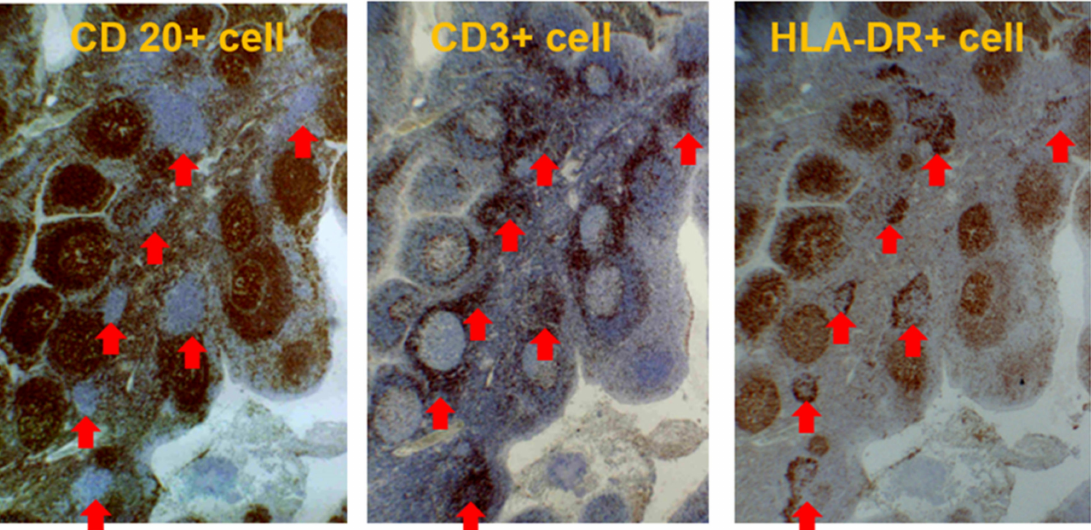
Figure 6. T cell nodules in palatine tonsil. T cell nodules (red arrows) consisting of CD3+CD20-HLA- DR+ cells present in the interfollicular area of the palatine tonsil (original magnification × 40). CX3C chemokine receptor 1 (CX3CR1), the only CX3CL1 (fractalkine) receptor, is expressed in human NK cells, NKT cells, monocytes, CD8+ T cells, and γδ T cells [29]. Fractalkine, a single ligand of CX3CR1, is a unique molecule that acts as both an adhesion molecule and a chemokine [30]. Fractalkine is localized on the vascular endothelial surface and strongly attracts CX3CR1+ cells without the help of other adhesion molecules, while the soluble form acts as a chemokine that induces the migration of CX3CR1+ cells. Conse- quently, both membrane-bound and soluble forms of fractalkine act as strong chemoattrac- tants for CX3CR1+ cells. Membrane-bound fractalkine can be induced in vascular endothe- lial cells by inflammatory cytokines such as tumor necrosis factor (TNF)- α , interferon- γ (IFN- γ ), and interleukin-1 (IL-1) [31]. Moreover, the serum level of soluble